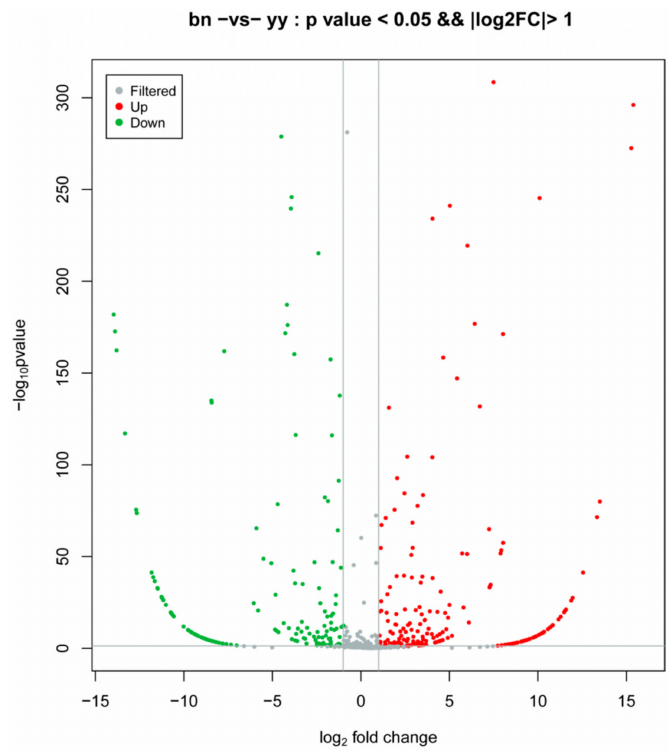
Figure 2. Volcano plot of DEMs showing the similarities and di ff erences between vegetative cells (yy) and dormant cysts (bn) of P. cristata . Each point / dot in the diagram represents a DEM. The red dots represented upregulation, whereas green dots indicated downregulation of DEMs. Gray dots represented DEMs that were not di ff erentially expressed. The x -axis displayed the log2 fold change, and the y -axis direction displayed the log10 p -value.